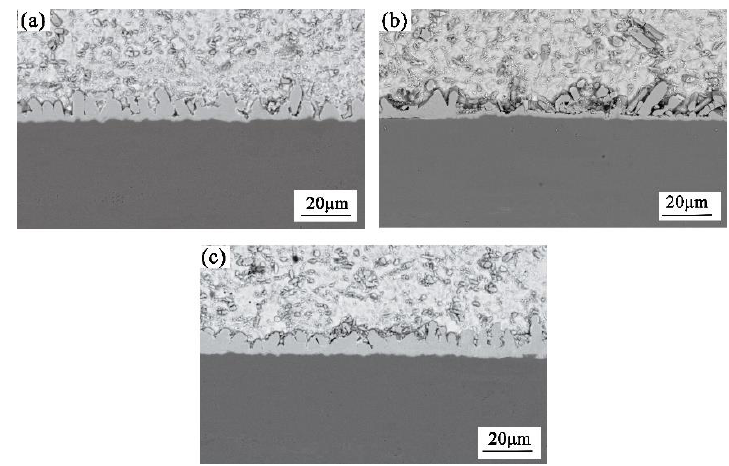
Figure 9. Interface IMC microstructure of Sn2.5Ag0.7Cu0.1RExNi / Cu solder joints after 500 thermal cycles. ( a ) 0Ni; ( b ) 0.05Ni; ( c ) 0.5Ni.